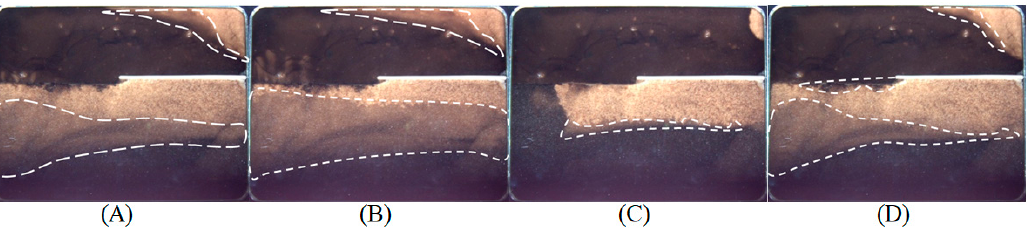
Figure 11. Distribution diagram of miscible zone formation.